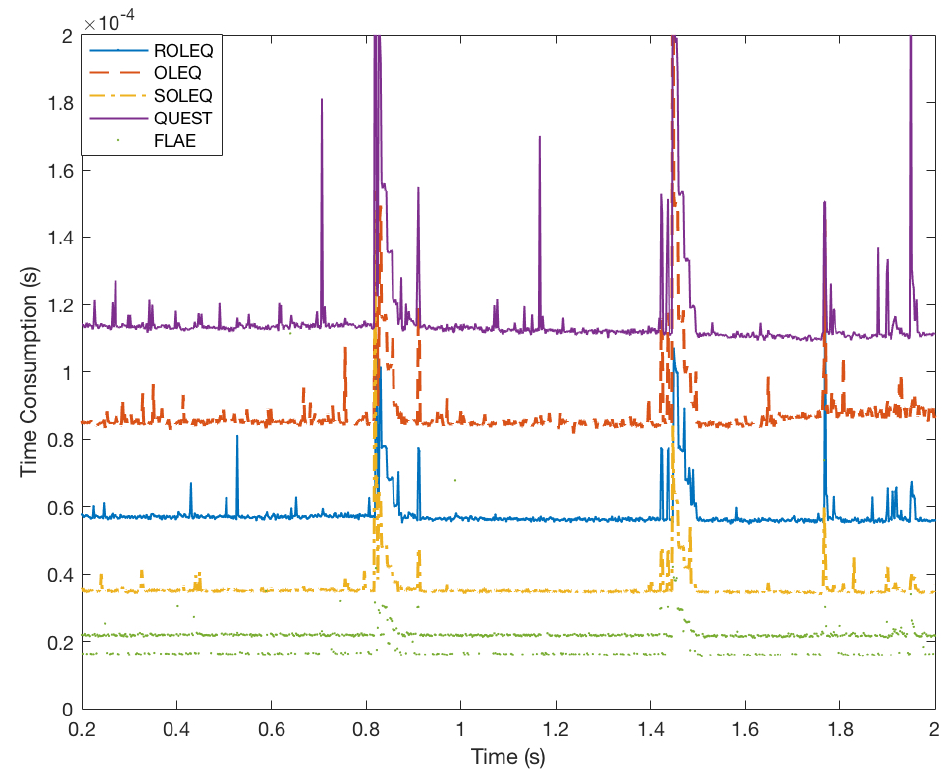
Figure 10. Time consumption of various algorithms.